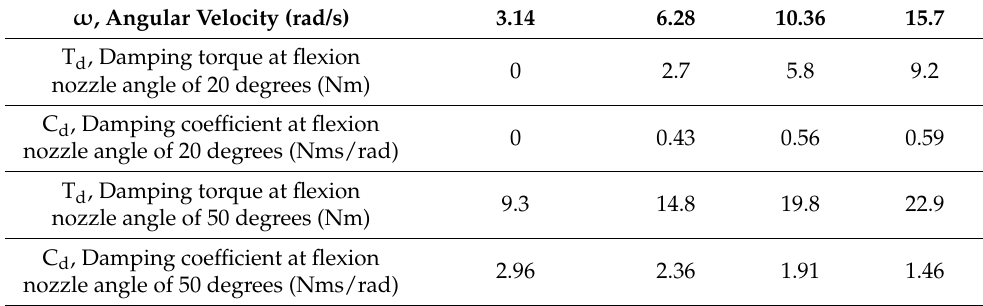
Table 3. The calculation of damping